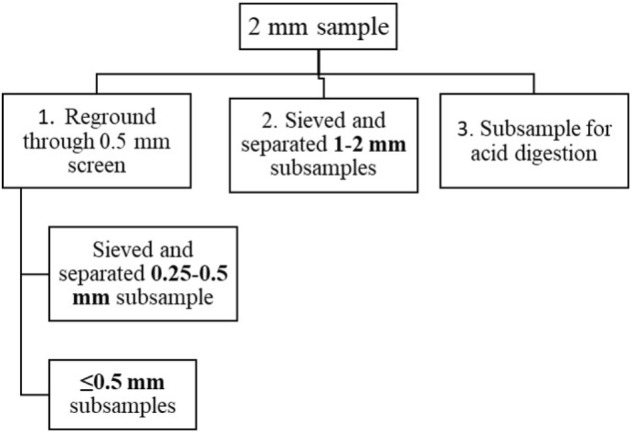
Schematic of subsampling of 2 mm samples into different particle sizes. 2 mm particle sized samples were obtained by grinding dried samples and allowed to pass through 2 mm screen of a cyclone mill.